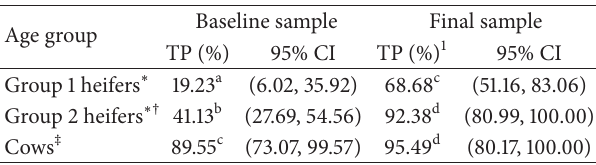
Table 3: True seroprevalence and 95% CI for Anaplasma marginale at baseline and final sampling times and 𝑃 values for McNemar’s test comparing TP within groups at baseline and final sampling for three cattle cohorts from a beef herd in California which were followed up for Anaplasma marginale seroconversion.